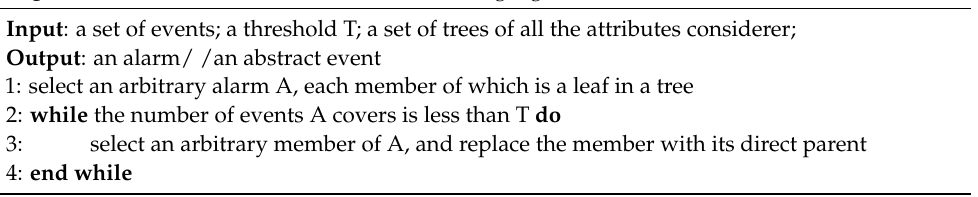
Algorithm 1 Julisch’s alarm hierarchical clustering